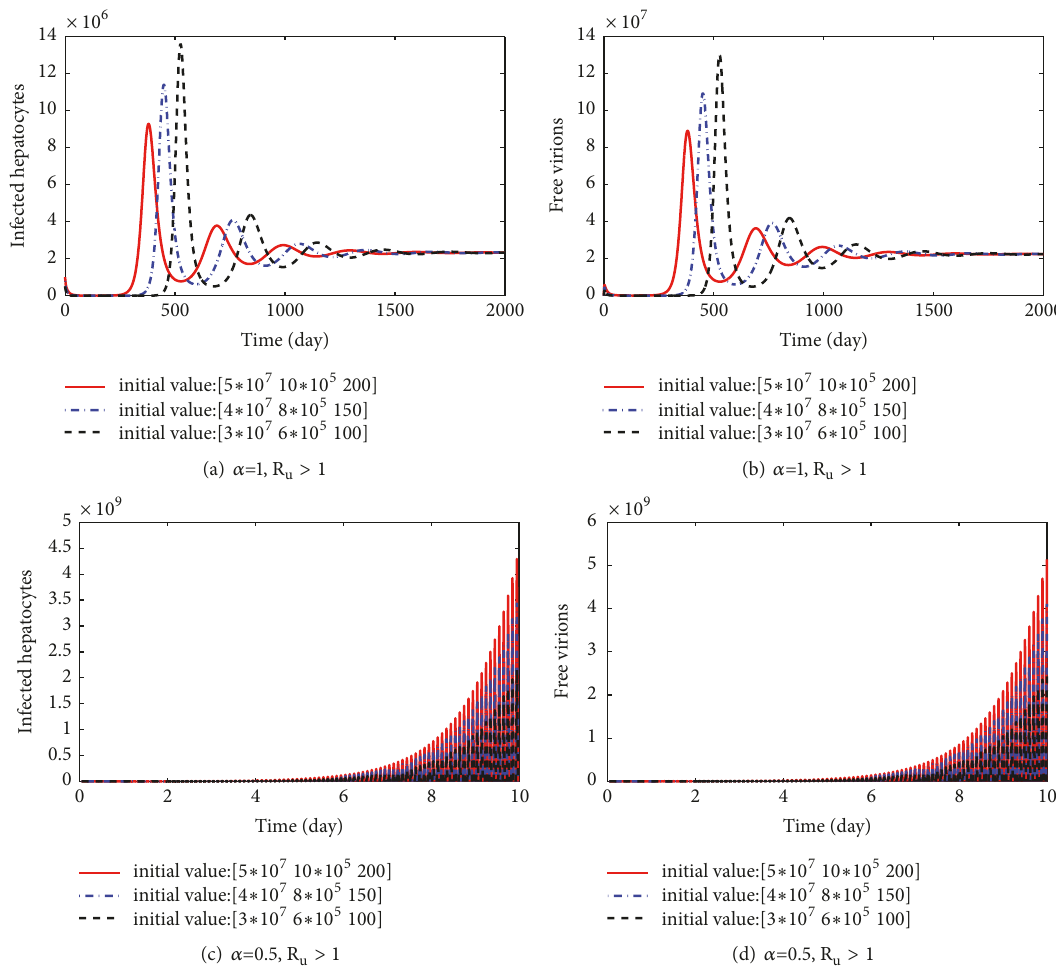
Figure 7: In this case, For different initial values: when 𝛼 = 1 , the endemic equilibrium 𝐸 ∗ 𝑢 is stable. However, when 𝛼 = 0.5 , the endemic equilibrium 𝐸 ∗ 𝑢 is